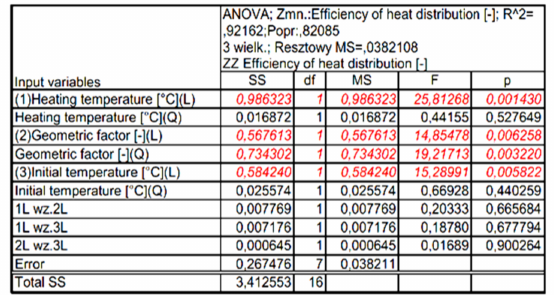
Figure 17. Summary of the results of ANOVA analysis of input variables on the value of the output variable, where: df, degrees of freedom; MS, pure error; SS, variance; F, statistic value, coefficient informing about the contribution of a given variable to the prediction; p, significance level, coefficient correlation; R 2 , regression coefficient.